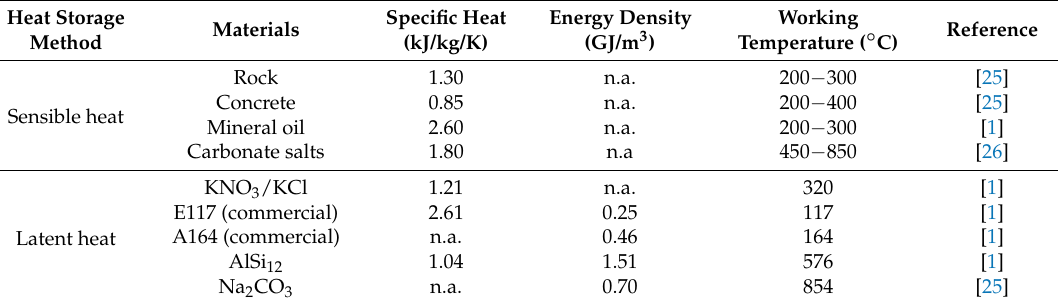
Table 2. Physical properties of different types of heat storage